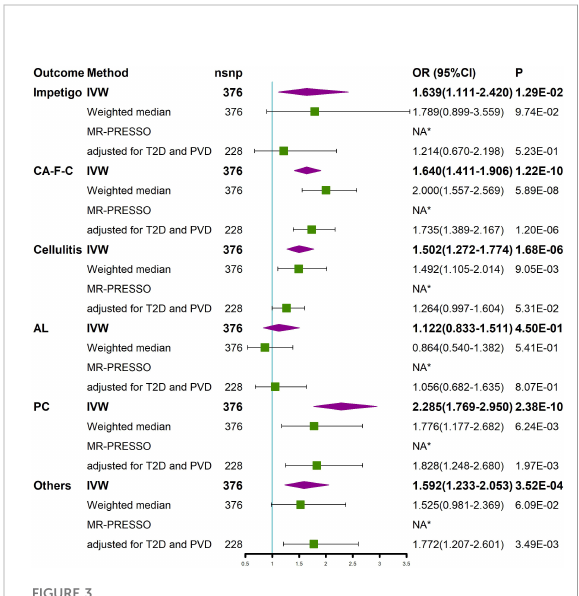
FIGURE 3 Univariable MR and multivariable MR analyses showed the causal relationship between BMI and different types of SSTIs. Univariable MR was performed using the IVW, weighted median, and MR- PRESSO methods. Multivariable MR was performed to assess the effect of BMI on different types of SSTIs after adjusting for T2D and PVD. *No outliers were detected. BMI, body mass index; IVW, inverse variance weighted; nsnp, number of single nucleotide polymorphism; OR, odds ratio; CI, con fi dence interval; MR- PRESSO, MR Pleiotropy REsidual Sum and Outlier; T2D, type 2 diabetes; PVD, peripheral vascular disease; CA-F-C, cutaneous abscess, furuncle and carbuncle; AL, acute lymphadenitis; PC, pilonidal cyst; Others, other local infections of skin and subcutaneous tissues; SSTIs, skin and soft tissue